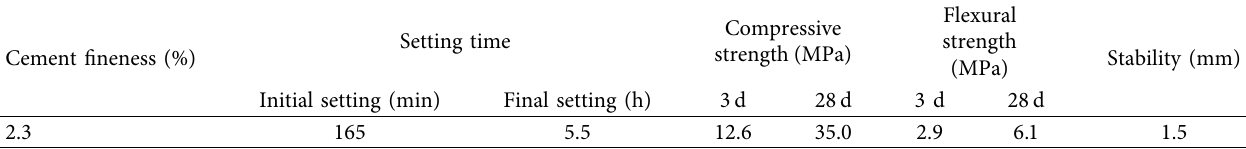
Table 2: Physical properties of cement.